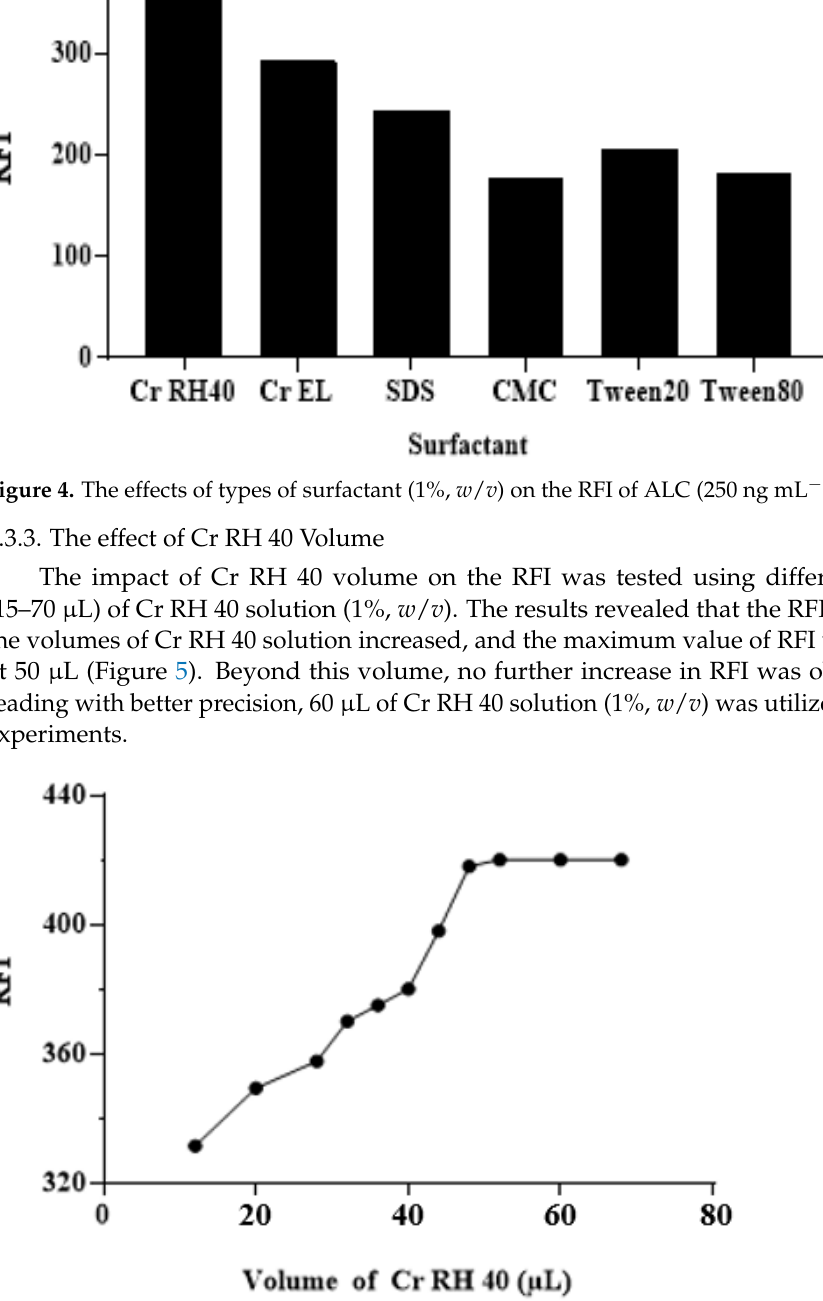
Figure 5. The effect of the volume of Cr RH 40 (1%, w / ν ) on the RFI of ALC (250 ng mL − 1 ).